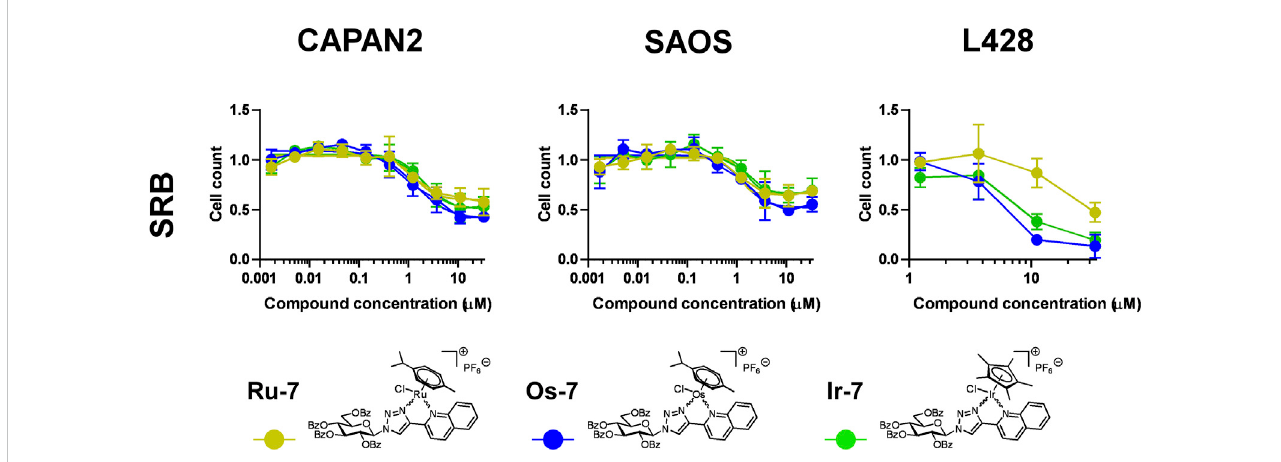
FIGURE 8 Assessment of quinoline-containing complexes Ru-7 , Os-7 , Ir-7 for cytostatic activity on other cancer cell lines. 3 × 10 3 Capan2 cells, 2 × 10 3 Saos cells and 8 × 10 3 L428 were plated to 96 well plates. Cells were treated with the compounds in the concentrations for 48 h. Then for Capan2 and Saos SRB assay wasperformed,L428cellswerecountedusingaBurkerchamber.Dataisrepresentedasaverage±SD,fromthreebiologicalreplicates;individualassayswere performed in duplicates. Values were normalized for vehicle treated cells, absorbance for vehicle treated cells equals to 1. Normality was checked using the Shapiro-Wilk test. The Saos Os-7 dataset was normalized using the Box-Cox method, other datasets had normal distribution. Each complex was individually assessed for statisticalsigni fi cance using One-way ANOVA testfollowed byDunnett ’ s post hoc test; all values werecomparedto thevaluesofthe lowest concentration. For better visibility the p values are presented in an excel sheet at https:// fi gshare.com/s/2c942a812caea8869a67. Non-linear regression was performed on the Capan2 and Saos